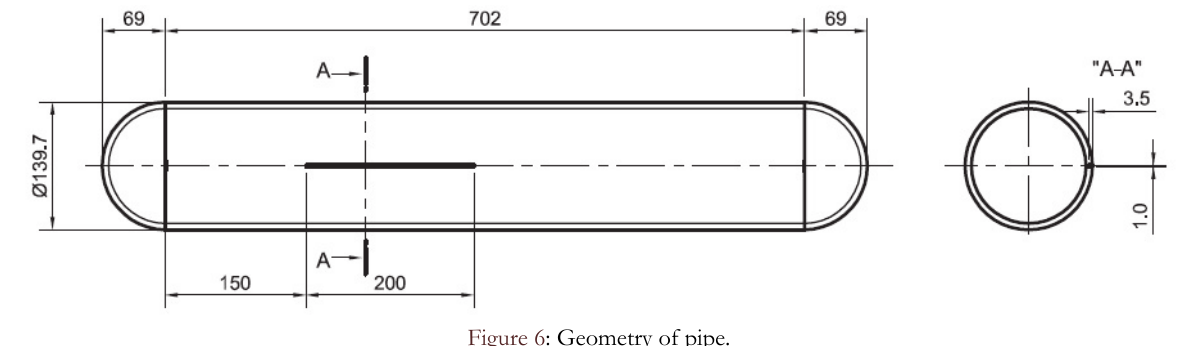
Figure 6: Geometry of